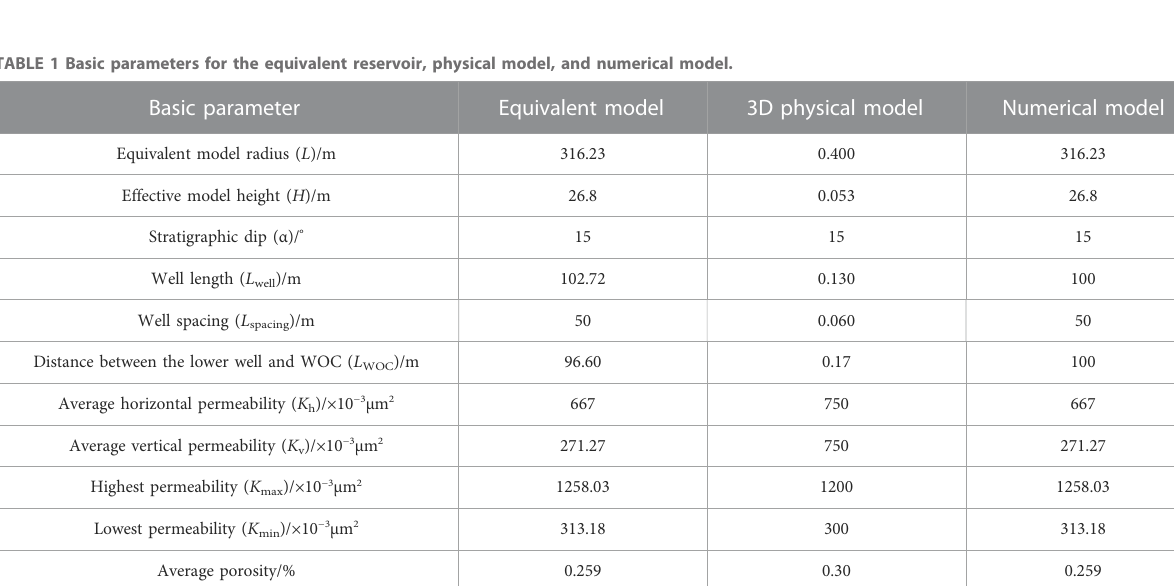
According to the calculations, the 3D physical model used for well-to-well interplay during the CO 2 huff-n-puff process had a diameter of 400 mm, a thickness of 53 mm, and a stratigraphic dip of 15 ° (Figure 3A). The horizontal well pair including P1H and P2H was established in the middle of the core. The lengths of P1H and P2H were both 130 mm, the spacing between P1H and P2H is 65 mm, and the distance between P1H and WOC was 120 mm (Figure 3B). The model was a heterogeneous core with an average permeability of 750 × 10 − 3 μ m 2 , upper layer permeability of 300 × 10 − 3 μ m 2 , and bottom layer permeability of 1200 × 10 − 3 μ m 2 . In order to achieve the different